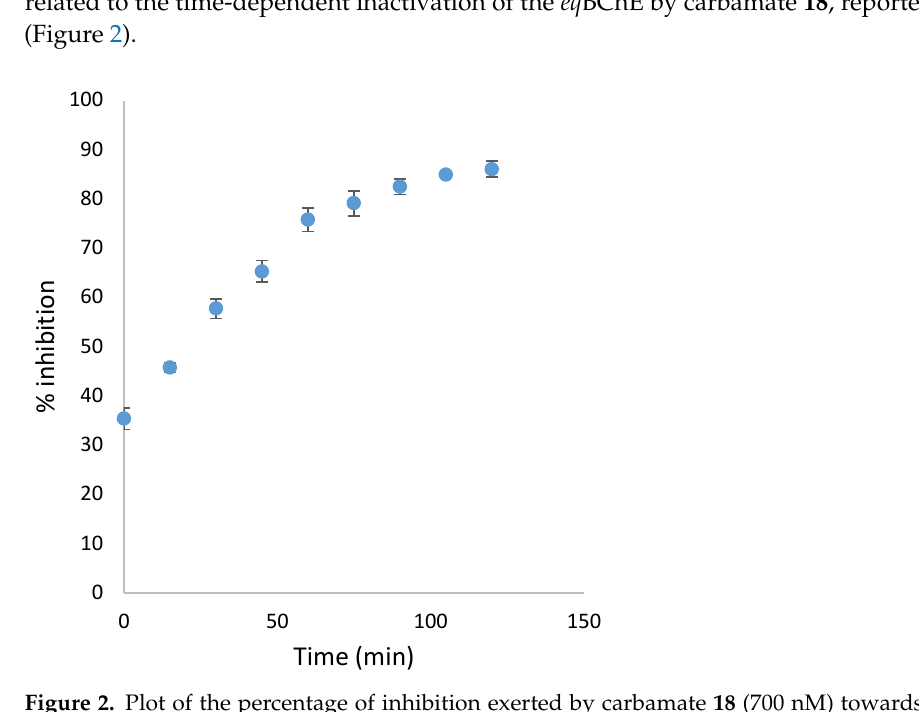
Figure 2. Plot of the percentage of inhibition exerted by carbamate 18 (700 nM) towards eq BChE (0.0833 U/mL), in presence of acetylthiocholine (100 µM), versus the incubation time.